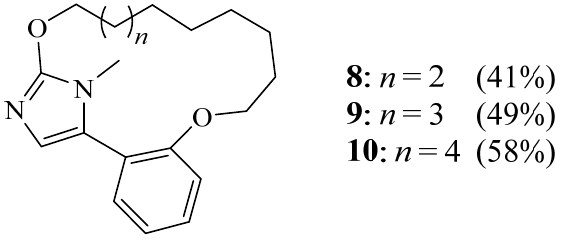
Figure 3. Structures of macrocycles 8 − 10. (Reprinted with permission from ref. [18]. Copyright 2011 John Wiley and Sons).